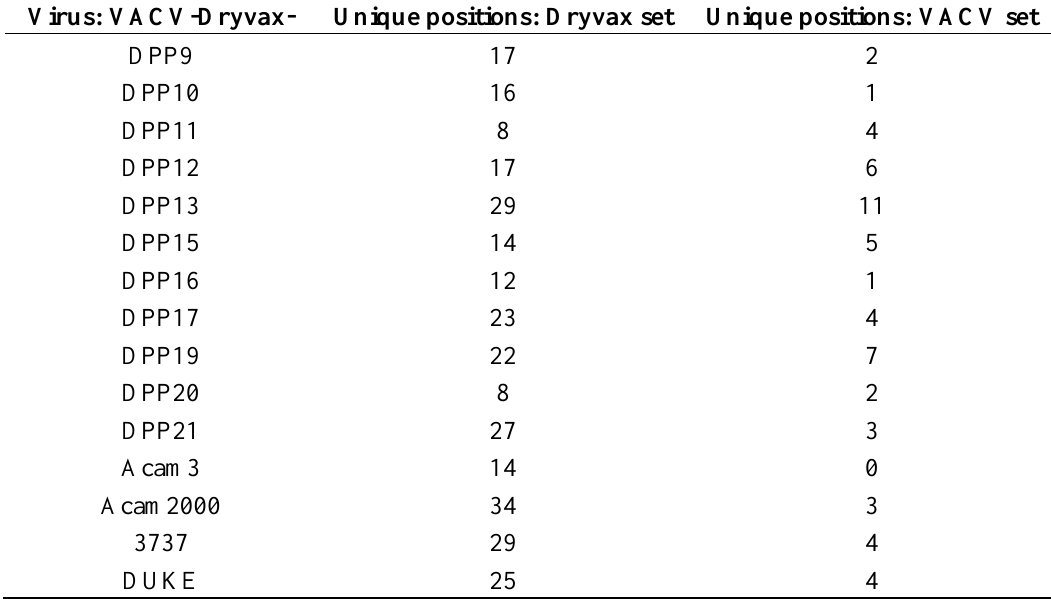
Table 1. Number of unique single nucleotide polymorphisms (SNPs) in the core region of the VACV-Dryvax viruses calculated within the Dryvax set and full VACV set of